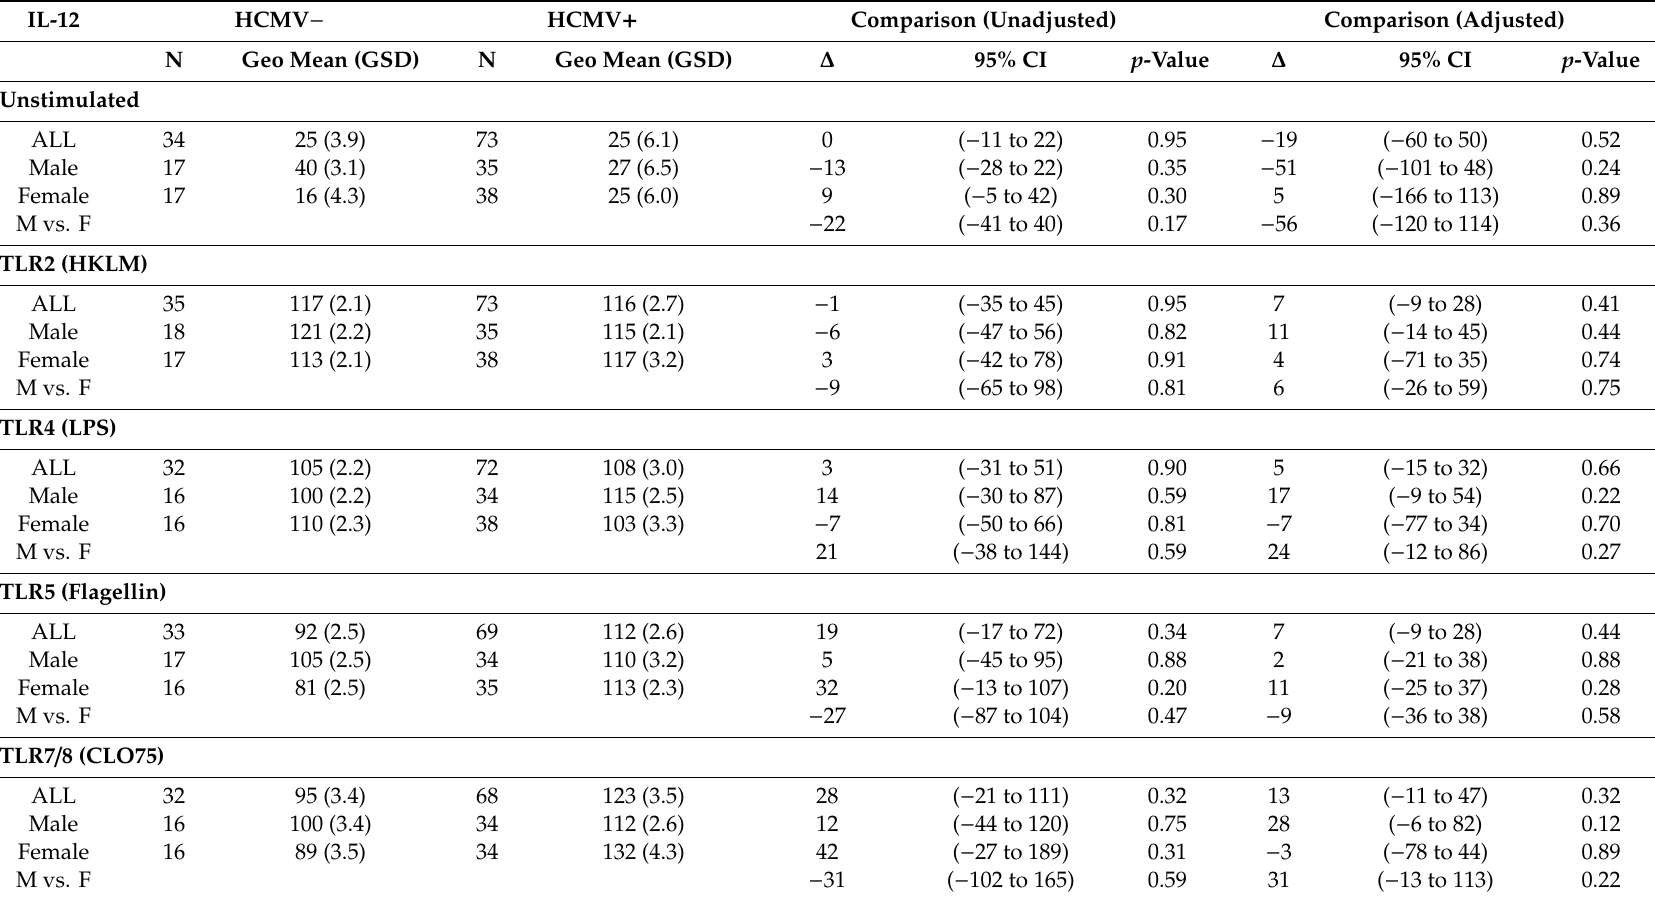
Table 5. E ff ect of HCMV infection TLR on ligand-stimulated IL-12(p70) responses by infant